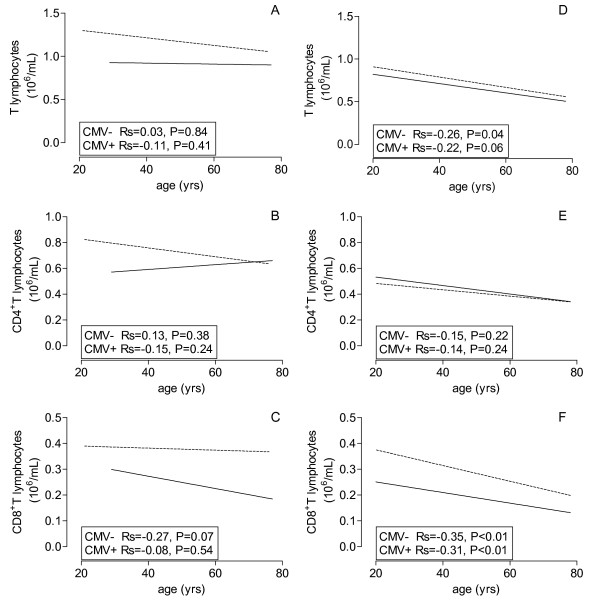
Age-related effects of CMV on composition of T lymphocytes. The lines of the best fits are shown for absolute numbers of T lymphocytes (A, D), CD4+ (B, E) and CD8+ T lymphocytes (C, F) of healthy volunteers (A, B, C) and ESRD patients (D, E, F) against age on X-axis and CMV serostatus (dotted line = CMV seropositive and closed line = CMV seronegative).